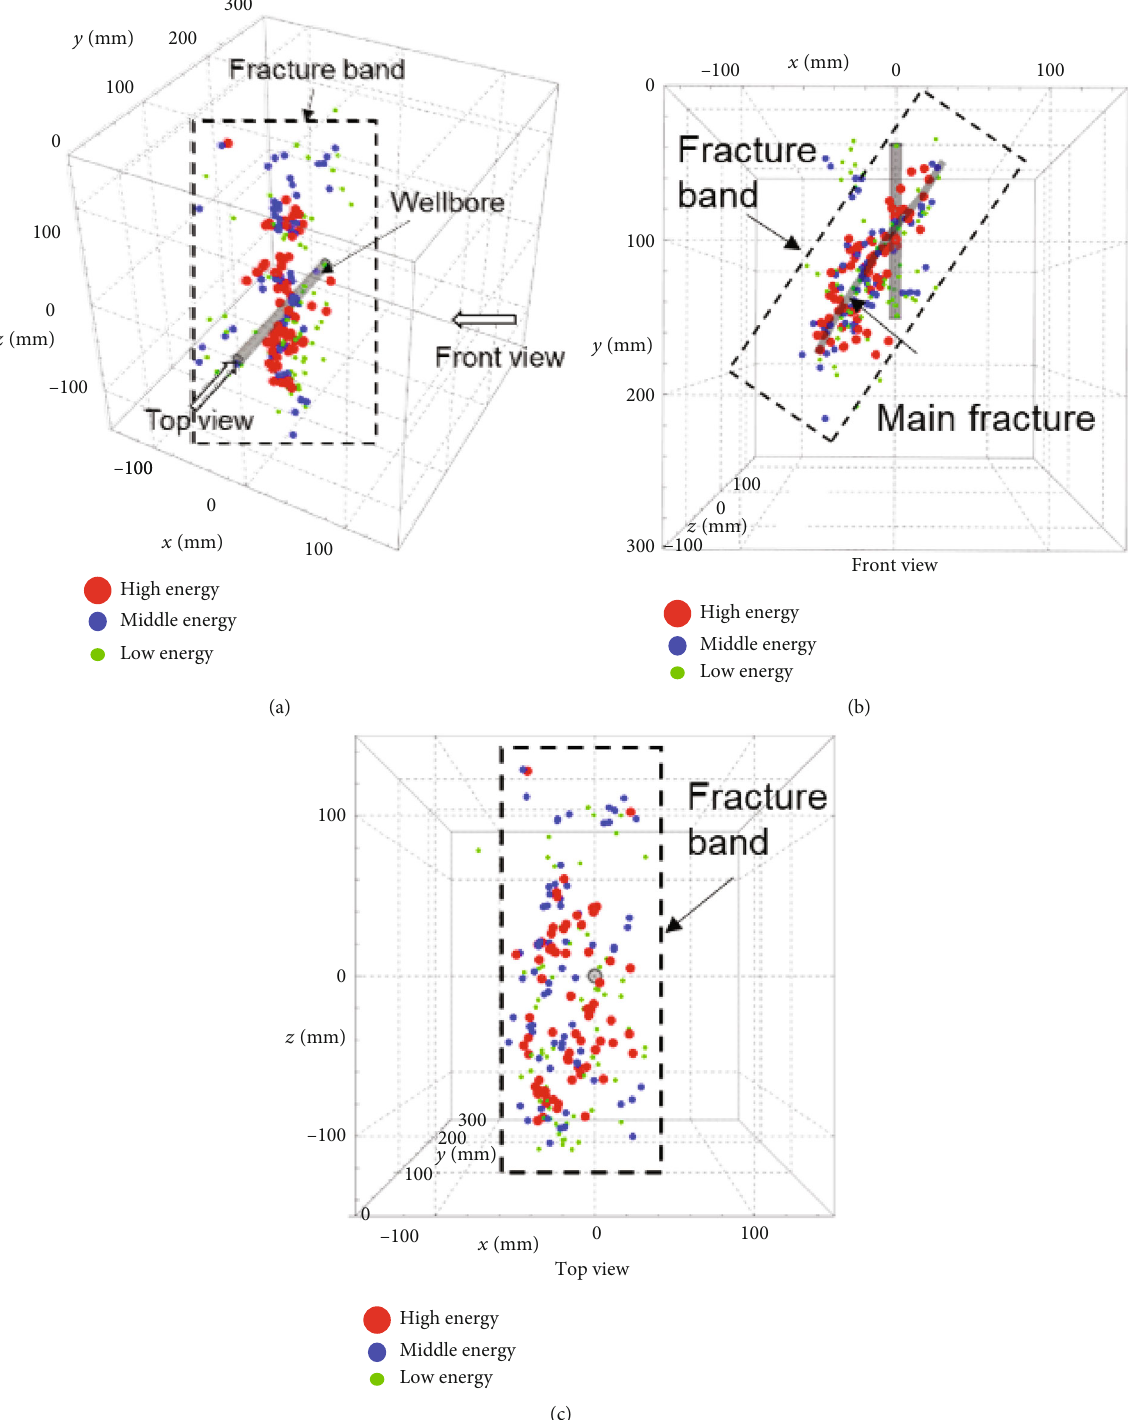
Figure 4: Di ff erent views of AE localization of specimen